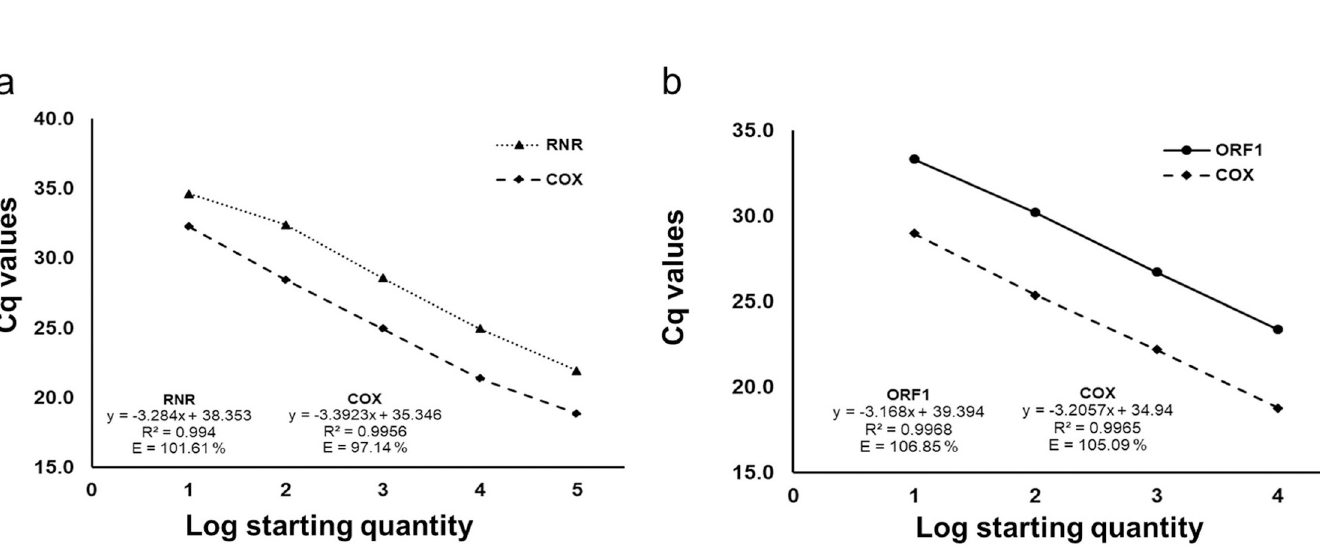
PLOS ONE | https://doi.org/10.1371/journal.pone.0242392 March 17,